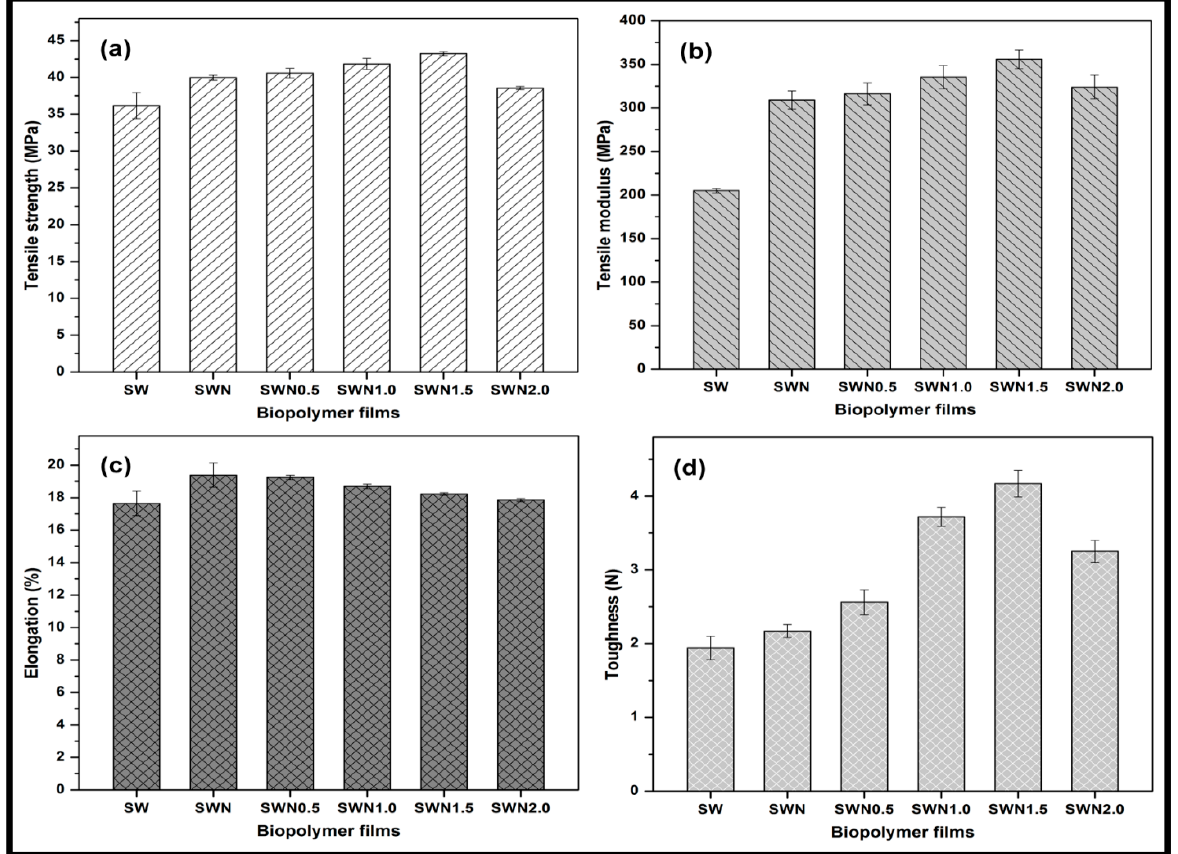
Figure 3. ( a ) Tensile strength and modulus ( b ) tensile modulus ( c ) elongation at break ( d ) toughness of seaweed, seaweed– neem, and seaweed–neem gamma irradiated film.